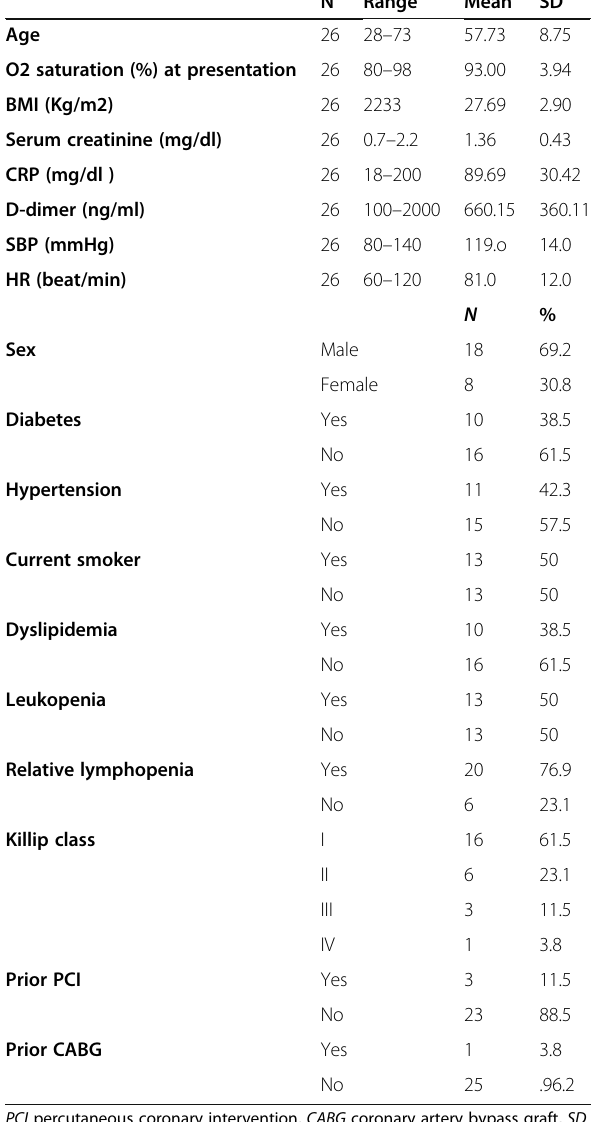
Table 1 Basal clinical